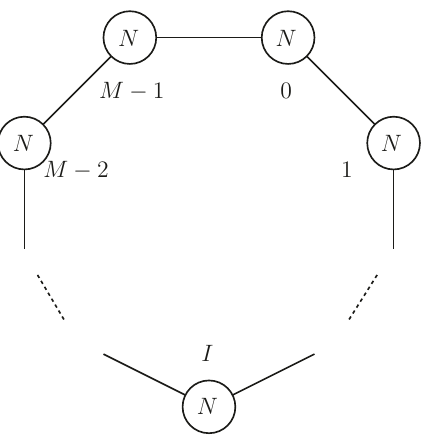
Figure 1 : The quiver diagram representing the N = 2 superconformal theory with gauge group SU( N ) × SU( N ) × . . . × SU( N ) and matter multiplets in the bi-fundamental repre-